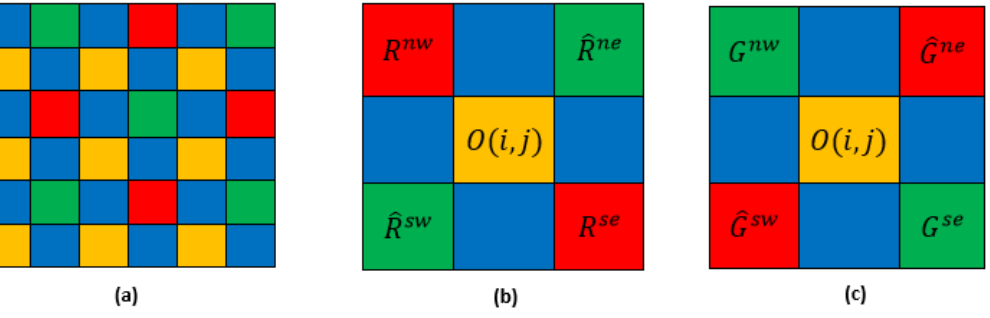
Figure 9. ( a ) Four ‐ band MSFA ( b ) neighborhood of O ‐ band for original and estimated red pixels ( c ) neighborhood of O ‐ band for original and estimated green pixels. ( c ) neighborhood of O-band for original and estimated green pixels.